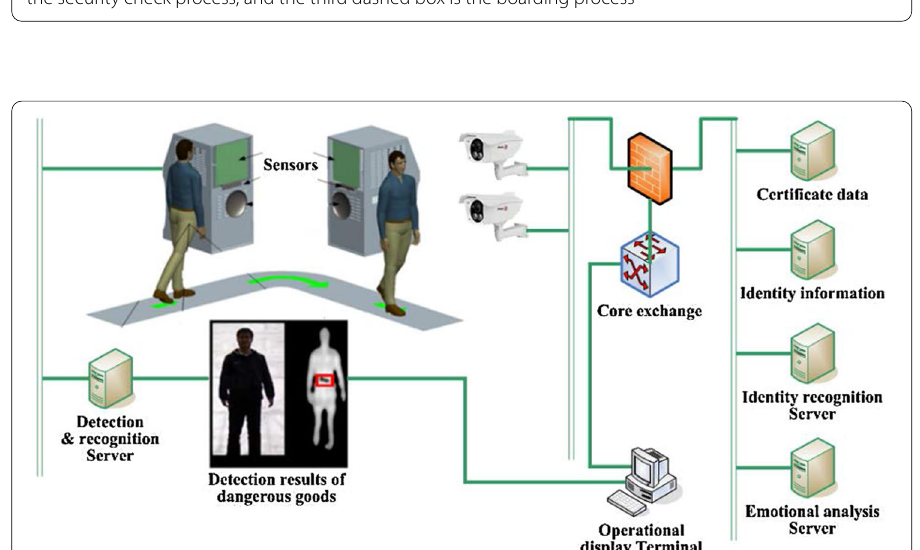
Fig. 2 Schematic diagram of a passenger information recognition system; description of our passenger information recognition system, the two cameras in the middle are used to capture facial images of